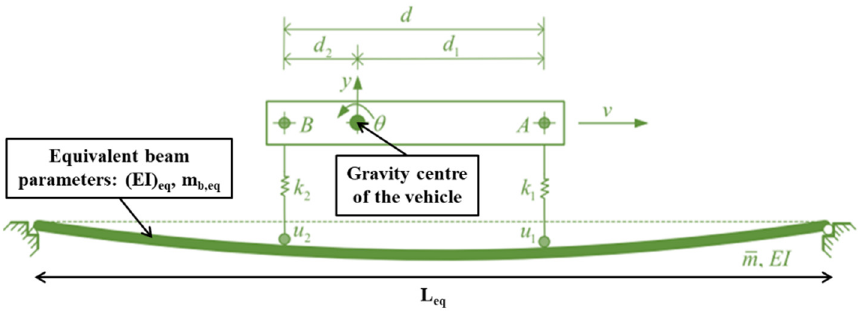
Figure 7. Asymmetric two-axles vehicle interacting with the bridge (modified from [28]).